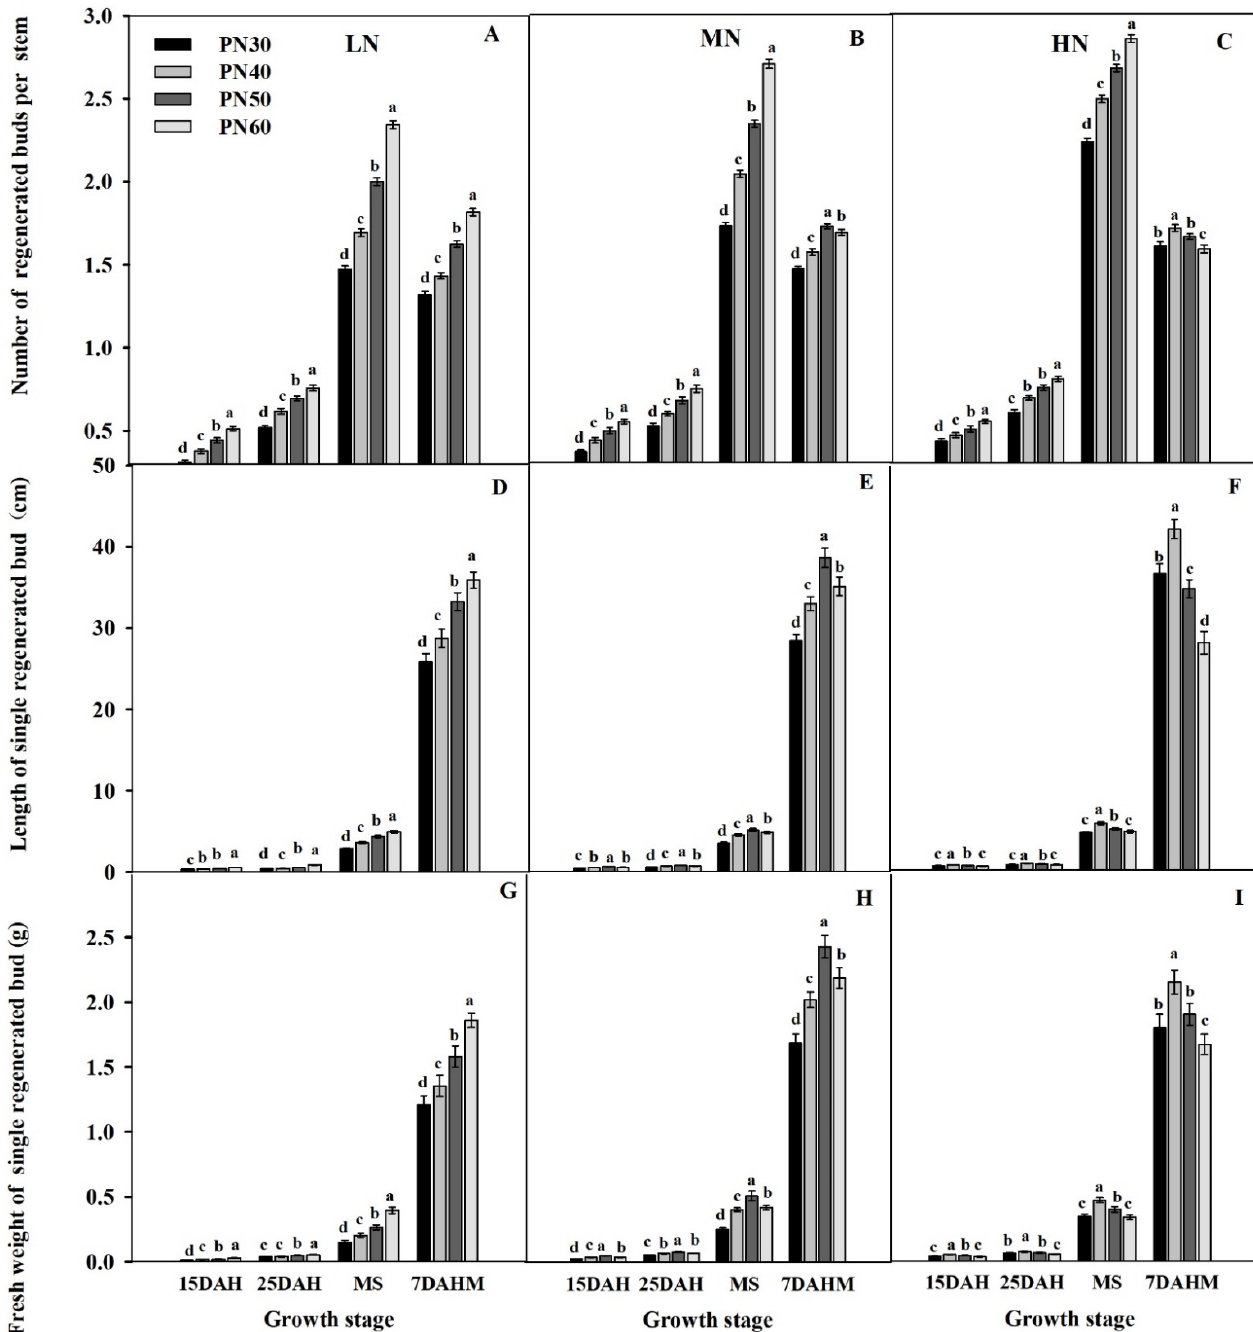
Figure 3. Effects of N rate and the ratio of the main crop on the number ( A – C ), length ( D – F ), and fresh weight ( G – I ) of regenerated buds. Error bars are ± SE. Note: LN, low N rate (the total amount of N applied was 100 kg ha − 1 ); MN, medium N rate (the total amount of N applied was 250 kg ha − 1 ); HN, high N rate (the total amount of N applied was 400 kg ha − 1 ). PN30, PN40, PN50, and PN60 correspond to N application ratios of basal tillering fertilizer to panicle fertilizer of 7:3, 6:4, 5:5, and 4:6, respectively. DAH, days after heading of the main crop. MS, maturity stage of the main crop. DAHM, days after harvest of the main crop. The different lowercase letters at the same growth stage indicate significant differences at the 5% probability level according to the LSD test.